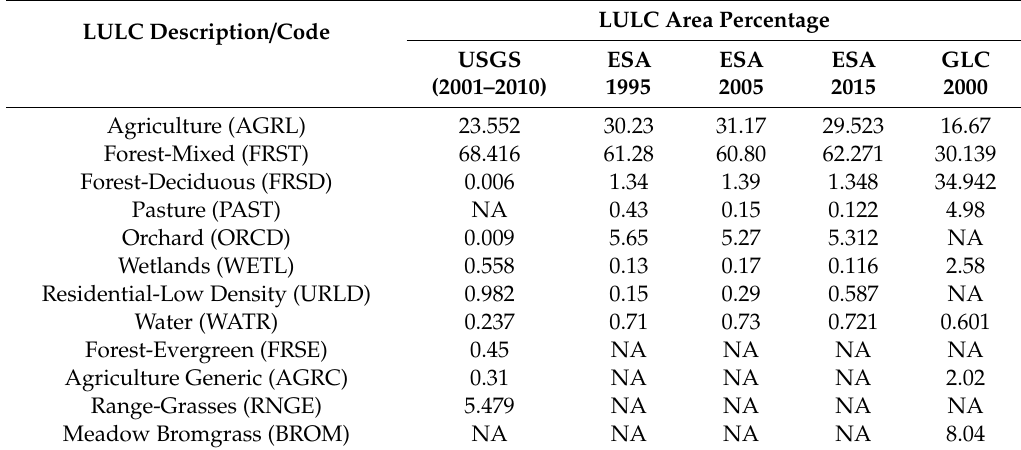
Figure 5. Simulated and observed discharge at Tianr Station. Table 6. SWAT land use